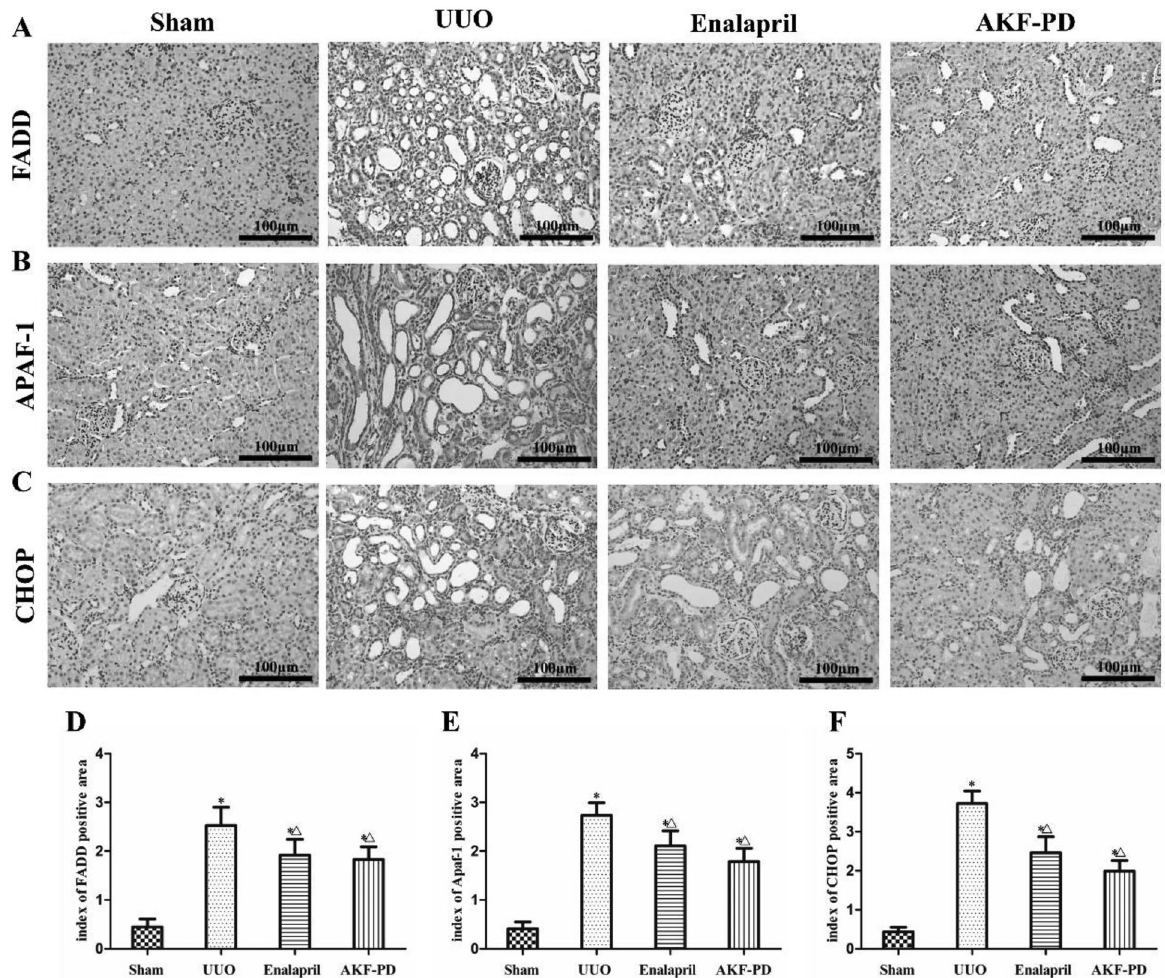
Figure 5. Fluorofenidone (AKF-PD) suppressed the protein expression of FADD, Apaf-1, and CHOP in the renal interstitium of rats in the unilateral urinary obstruction (UUO) group. Immunohistochemical results of FADD ( A ), Apaf-1 ( B ), and CHOP ( C ) in the sham, UUO, UUO + enalapril, and UUO + AKF-PD groups (200 (cid:3) magni fi cation, bar: 100 m m). D , E , and F , Semiquantitative analysis results of the protein expression of FADD, Apaf-1, and CHOP. Data are reported as means ± SD. *P o 0.05 vs the sham group. W P o 0.05 vs the UUO group